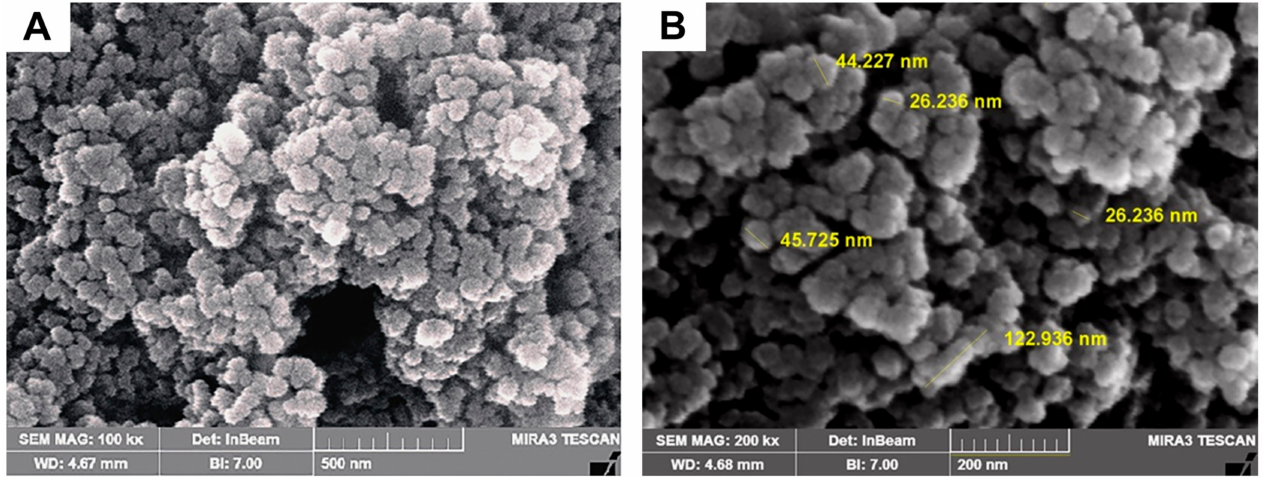
Figure 5. SEM images of green synthesized AgNPs 0.2% flaxseed extract as illustrated in ( A ) low and ( B ) high SEM magnification SEM images, respectively.